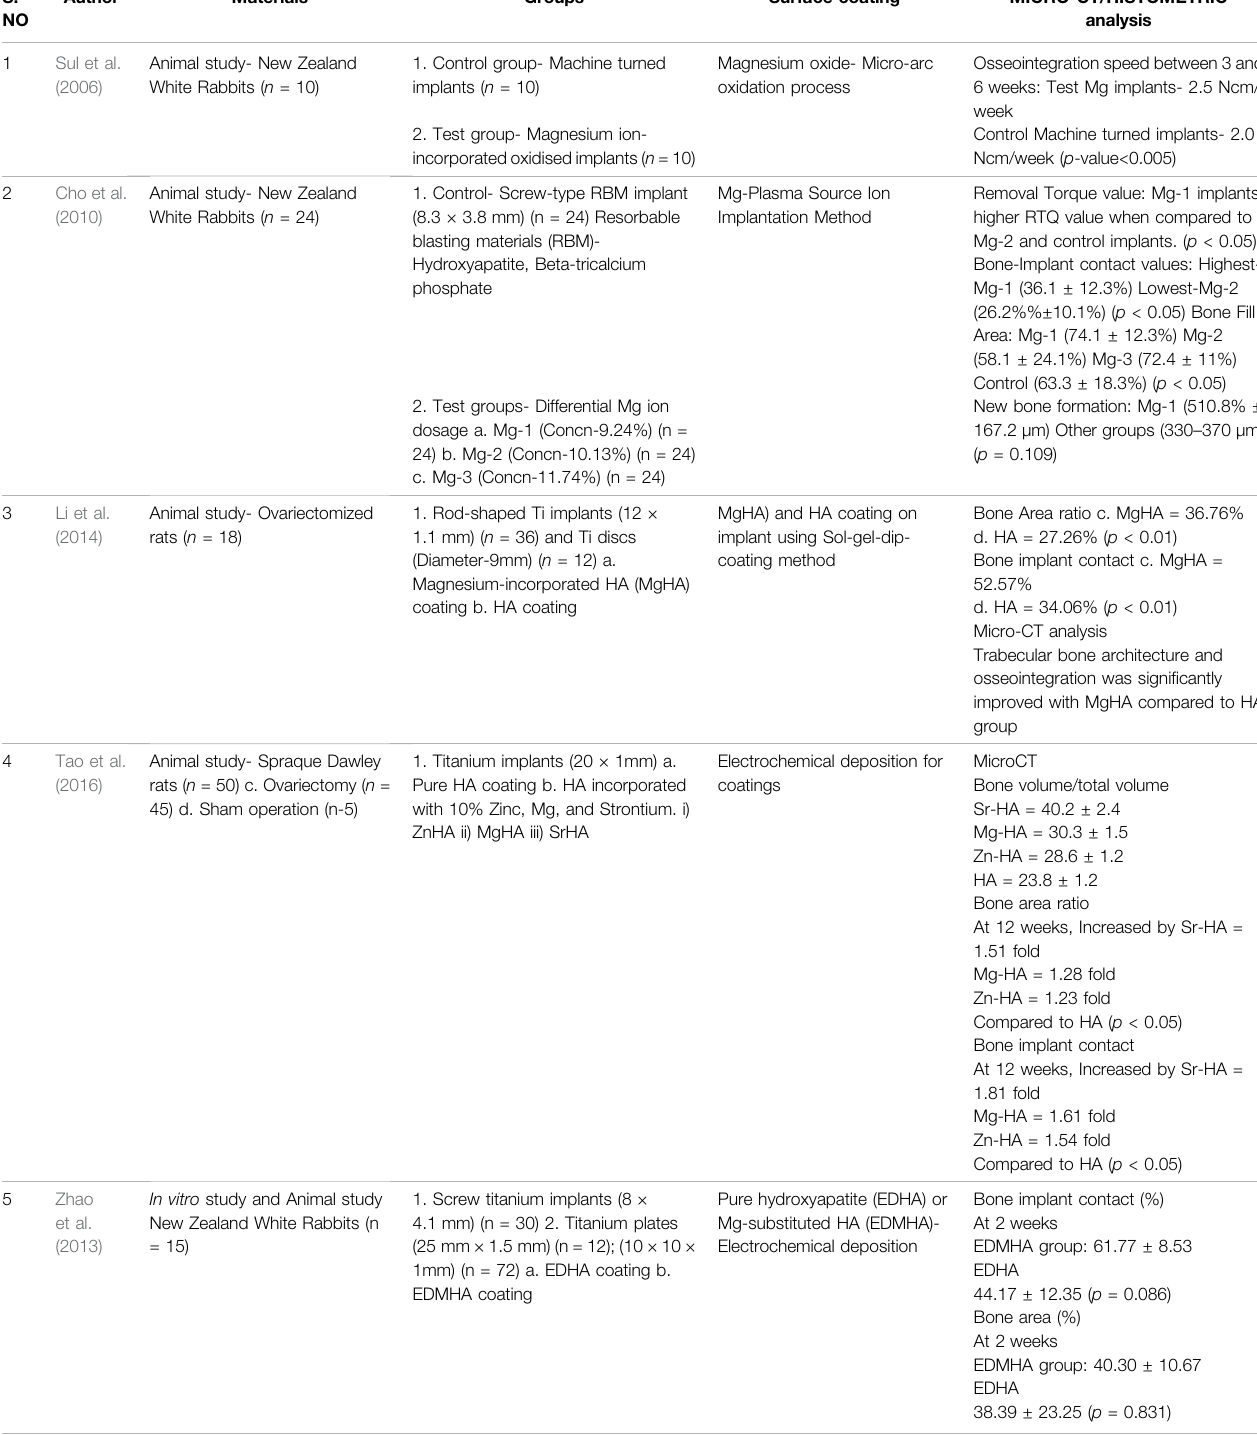
TABLE 3 | Summary of results of animal models observed for main outcome